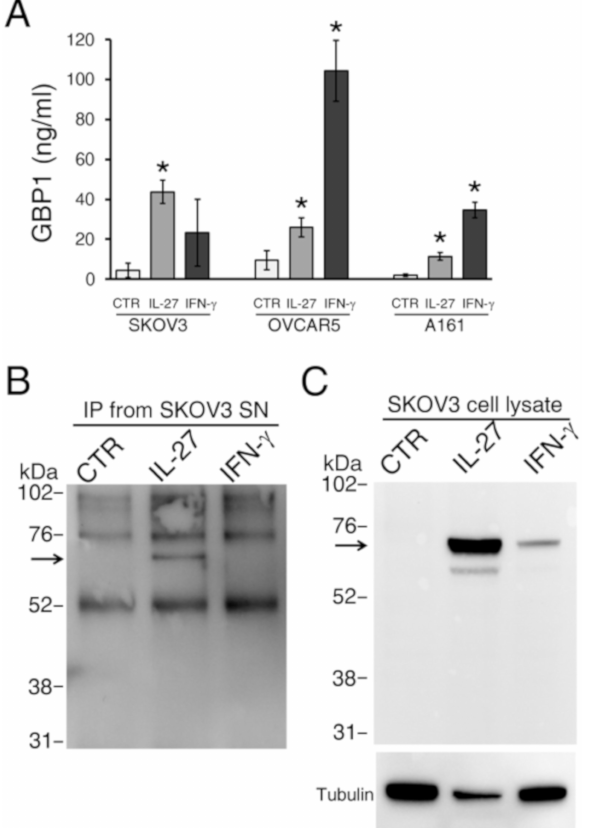
Figure 3. IL-27 or IFN- γ induces GBP1 secretion by EOC cell lines or primary culture, in vitro. ( A ) A GBP1-specific ELISA assay shows increased levels of GBP1 in cell culture supernatants of IL-27 or IFN- γ -stimulated SKOV3 or OVCAR5 cell lines or A161 primary culture. Data for SKOV3 and OVCAR5 represent the mean ± SD of three di ff erent experiments (* p < 0.01). ( B ) Western blot analysis of anti-GBP1-immunoprecipitated molecules from the supernatant (SN) of IL-27-stimulated SKOV3 cells shows an approximately 67 kDa band (arrow), which corresponds to the full-length GBP1 form. ( C ) Western blot analysis of GBP1 in the corresponding cell lysates. Tubulin is shown as a loading